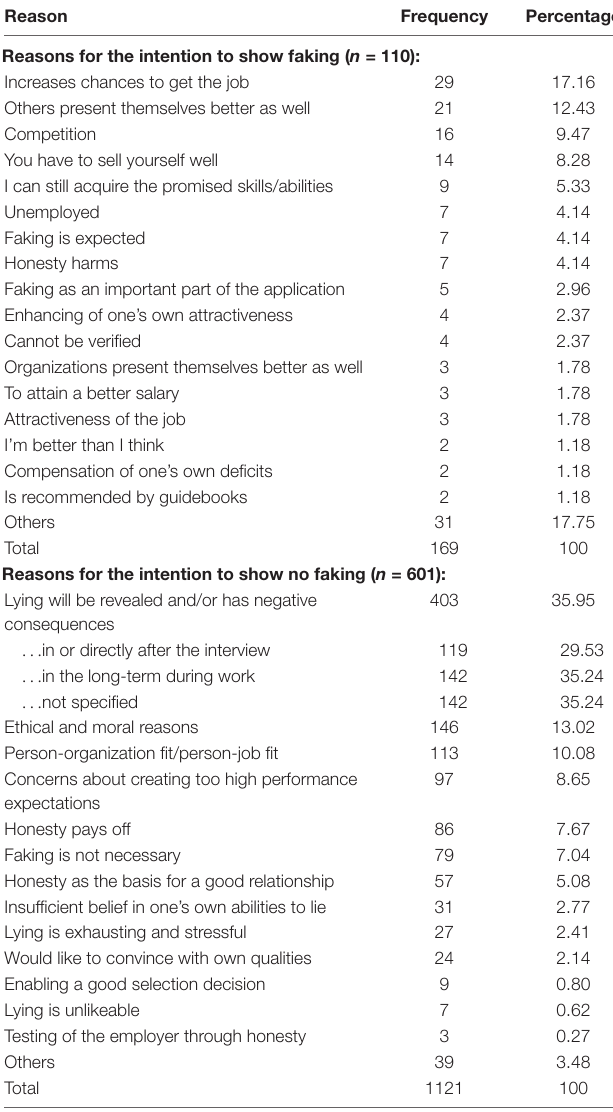
TABLE 6 | Reasons for the intention to show vs. not to show